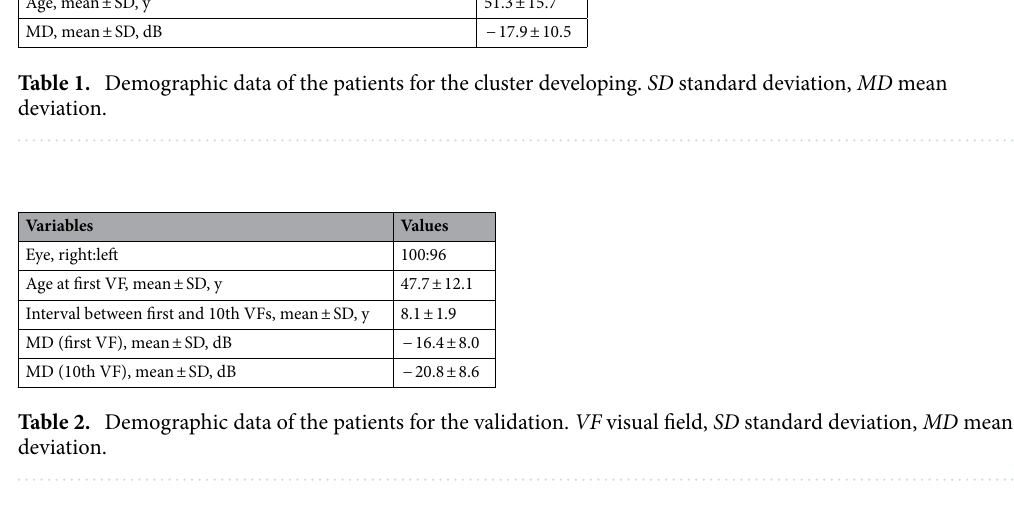
algorithm 20 for the training data. VF mapping for glaucoma (29 sectors: S2 mapping; Fig. 1B) established with